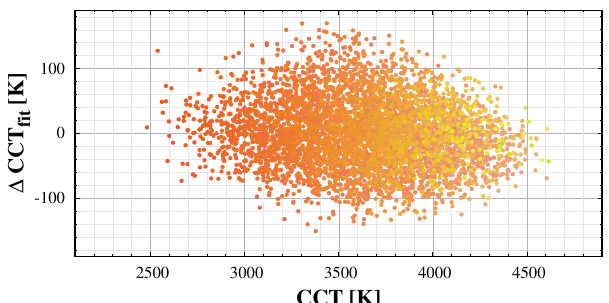
Figure 7. The error of the quadratic fit of correlated colour temperature (CCT) to the camera band-averaged spectral